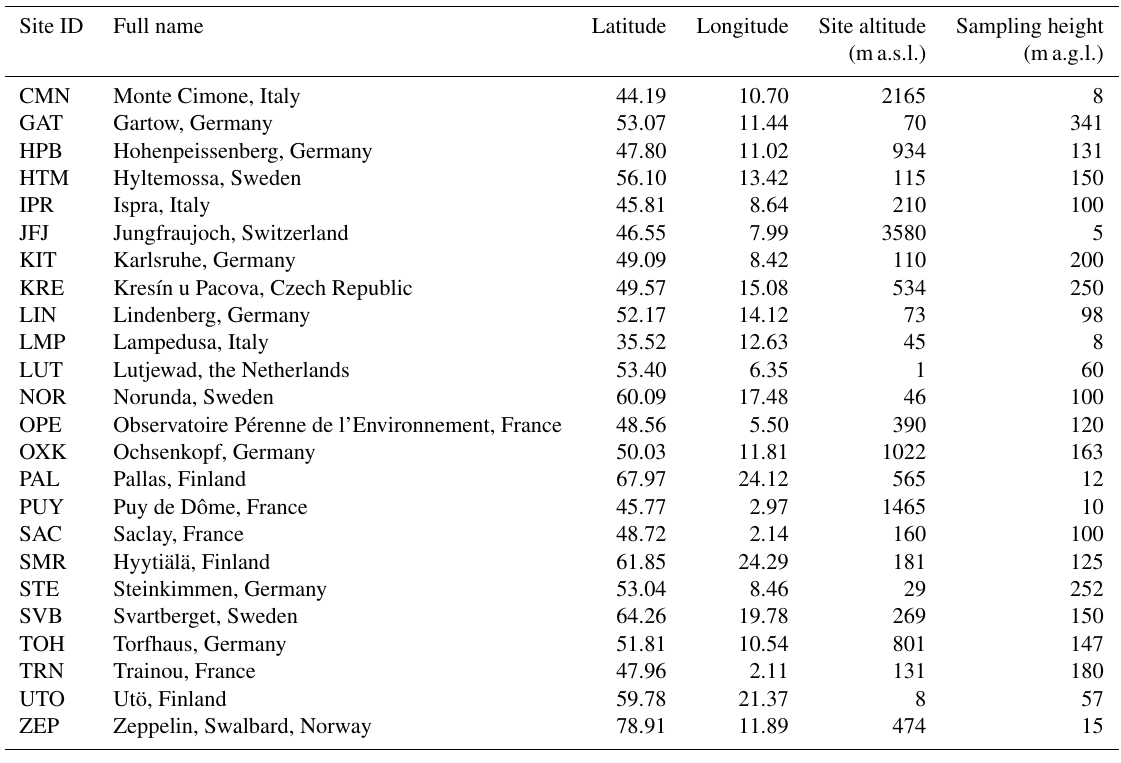
Table 1. List of sites in the ICOS network (only those in geographical Europe are included). The sampling height that was used in this study is shown, which is the highest sampling height at each site.